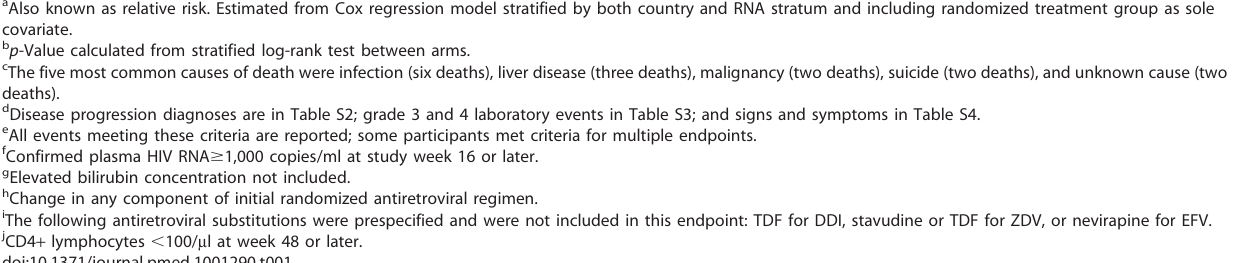
(Table S3). Participants assigned to ATV + DDI + FTC were more